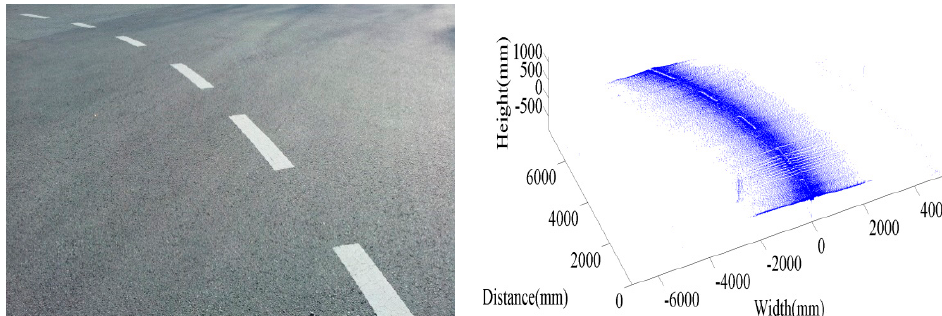
Figure 15. The 3D Road map of a discontinuous lane.